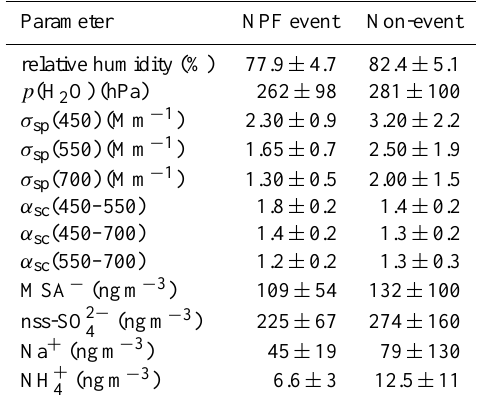
Table 2. Comparison of selected meteorological and aerosol light scattering parameters as well as ionic composition of the aerosol (all items in mean ± SD) during days with NPF as characterized in Table 2 and non-event days. The comparison is restricted to the summer months (January–March). Parameter NPF event Non-event relative humidity (%) 77.9 ±